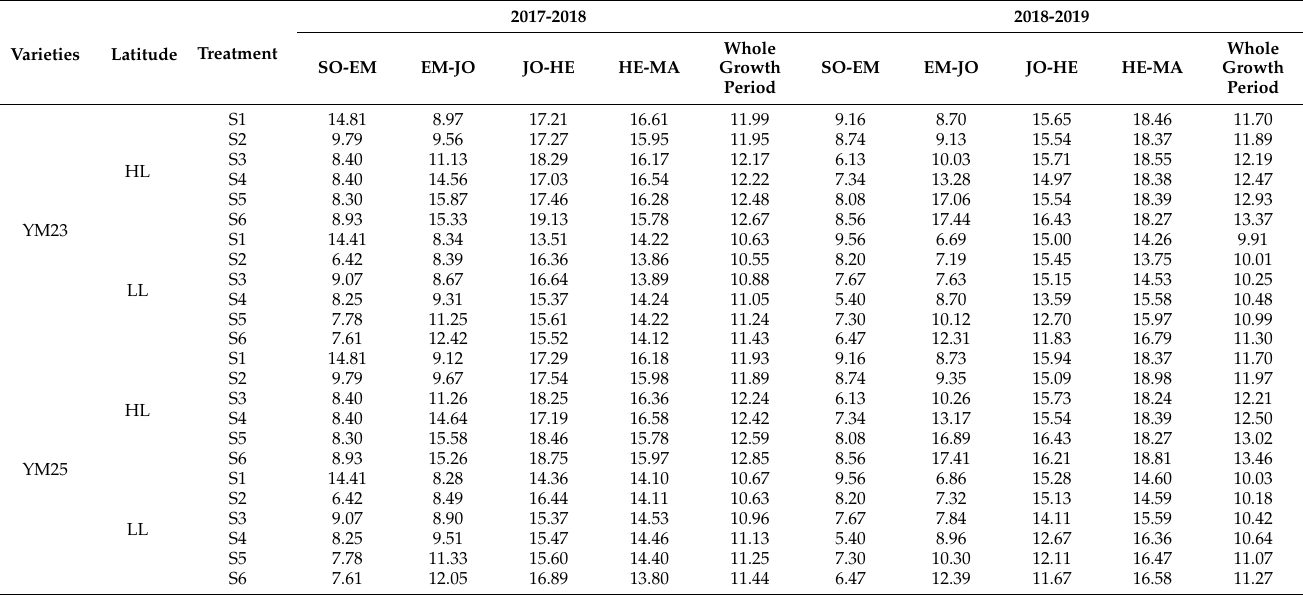
Table 4. Differences in mean daily cumulative solar radiation at different latitudes and sowing dates (MJ m − 2 d − 1 ).